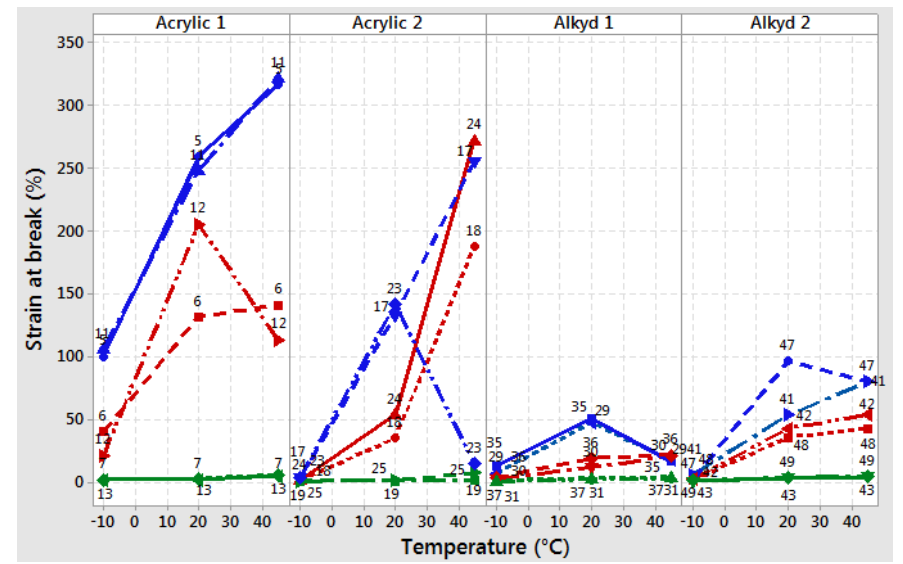
Figure 5. Influence of coating formulation on strain at break for the three test temperatures (in blue: clear PVC; in red: low PVC; in green: high PVC).